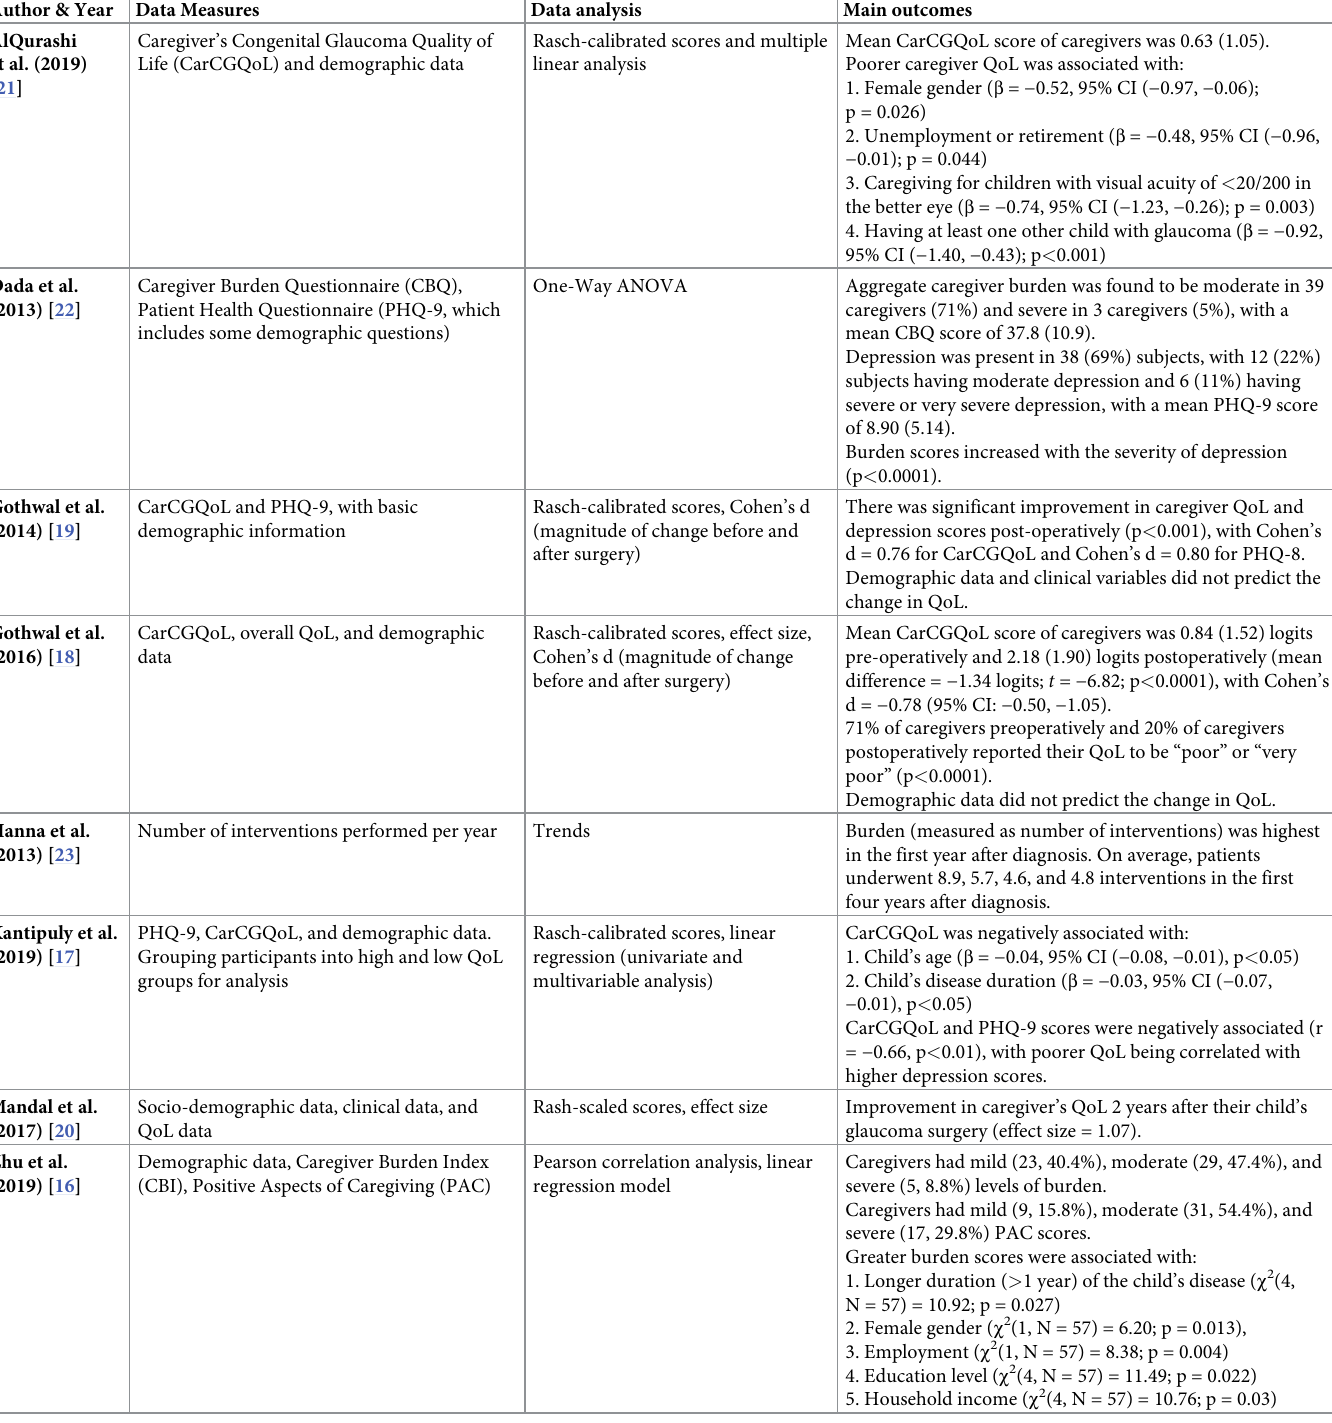
Table 2. Quality of life scales used and outcomes of included studies. Abbreviations: CarCGQol (Caregiver’s Congenital Glaucoma Quality of Life), CBQ (Caregiver Burden Questionnaire), PHQ-9 (Patient Health Questionnaire), CBI (Caregiver Burden Index), PAC (Positive Aspects of